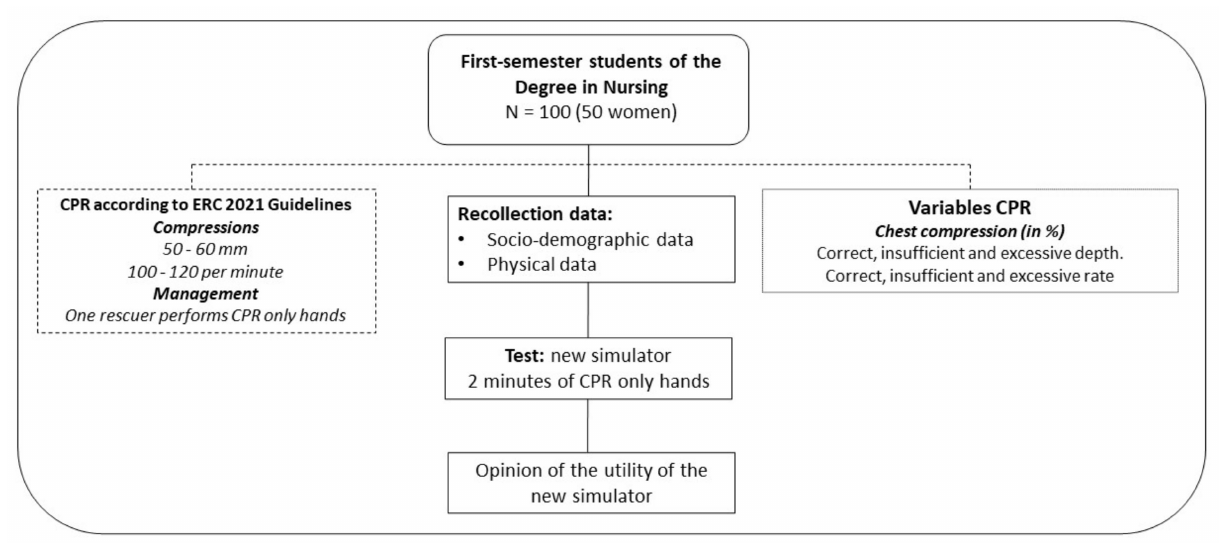
Figure 3. Study flow